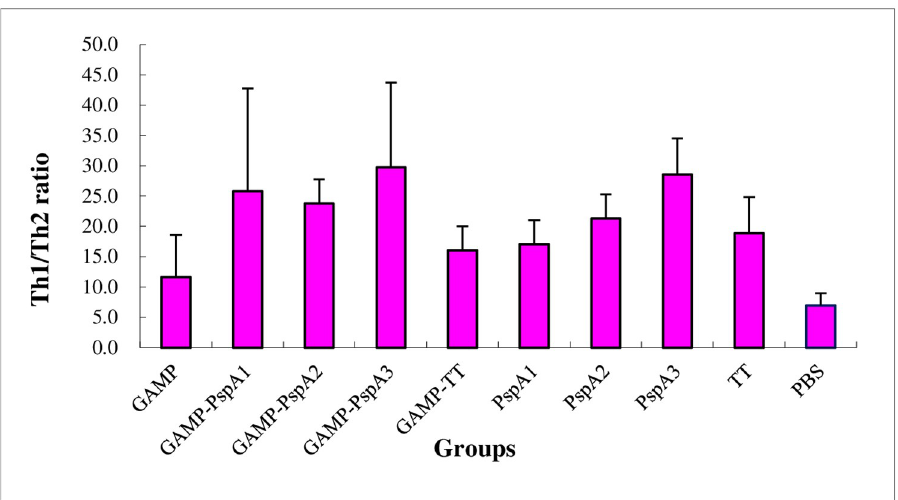
Fig 3. Results of FCM: Th1/Th2 ratio of the conjugated and unconjugated GAMP.